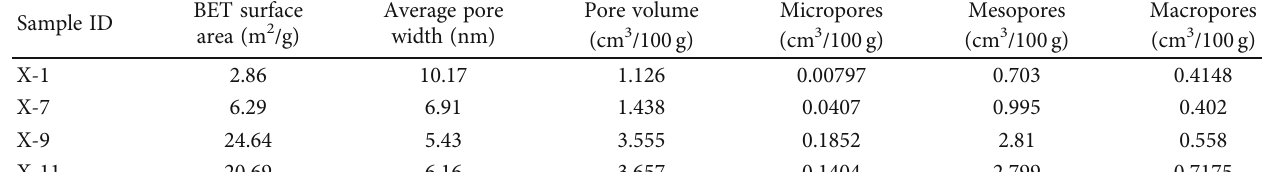
Table 2: Main pore structure parameters obtain from LNP tests for four facies. Sample ID